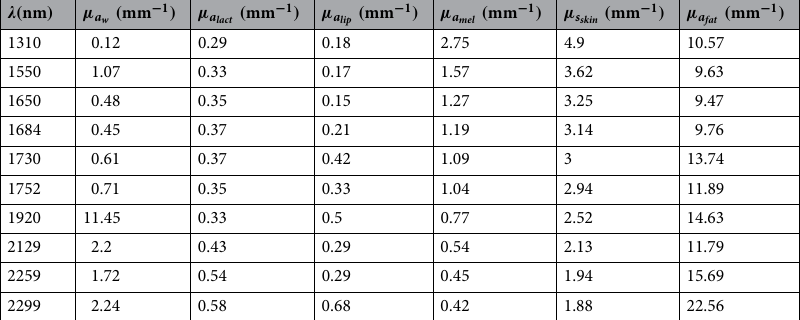
), lactate ( µ a ), lipid ( µ a ), w lip lact ) are illustrated at the fat